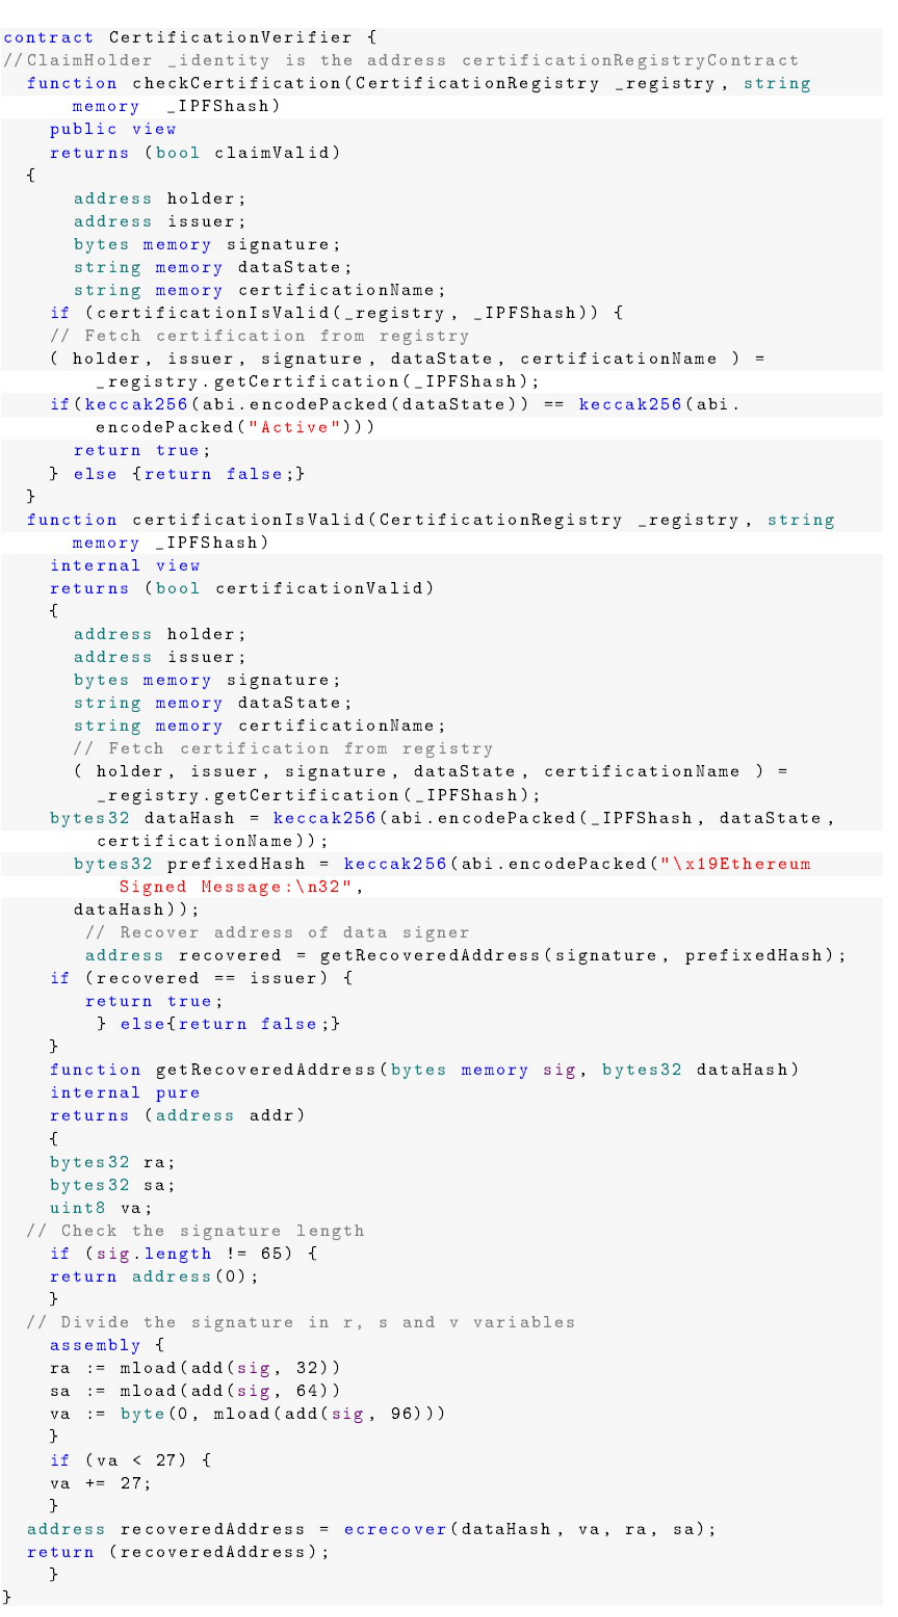
Figure 4. Solidity smart contract